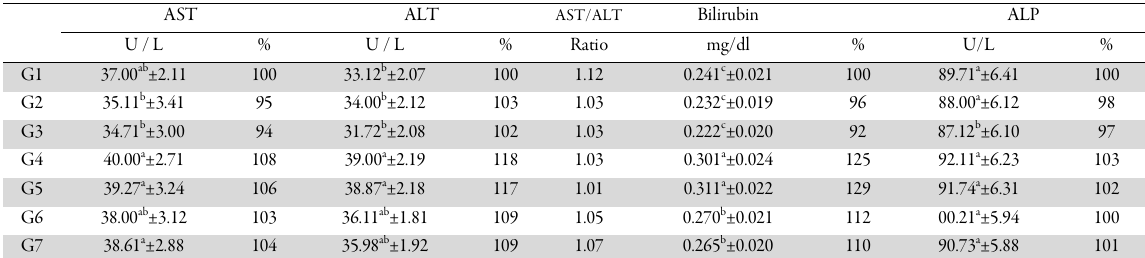
Table 5. Liver function of young mice groups treated by color wheat biscuits AST ALT AST/ALT Bilirubin